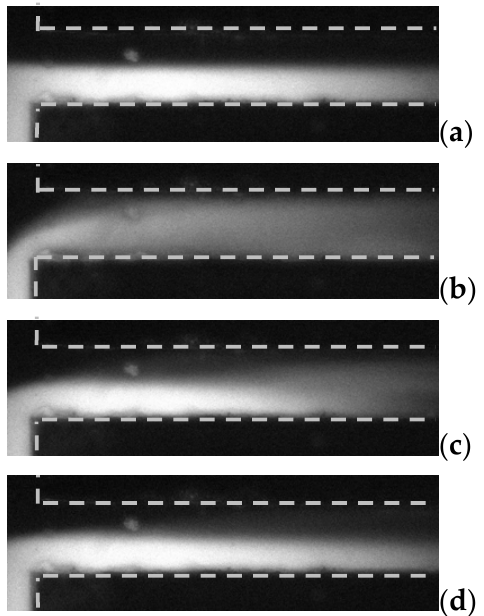
9 of 15 ( f ) Figure 6. Visualization and comparison of mixing results in microchannels with different frequen- cies of AC and DC signals. Here, 𝛾 = 10 and 𝐸 (cid:3002) = 1000 V/cm. ( a ) DC, ( b ) 𝑓 (cid:3002)(cid:3004) = 10 KHz, ( c ) 𝑓 (cid:3002)(cid:3004) = 1 MHz, ( d ) 𝑓 (cid:3002)(cid:3004) = 2 MHz, and ( e ) comparison of concentration profile in transverse direction at 𝑥 = 2.3𝑤 from the channel entrance with AC signal. ( f ) Mixing index varying along streamwise direc-